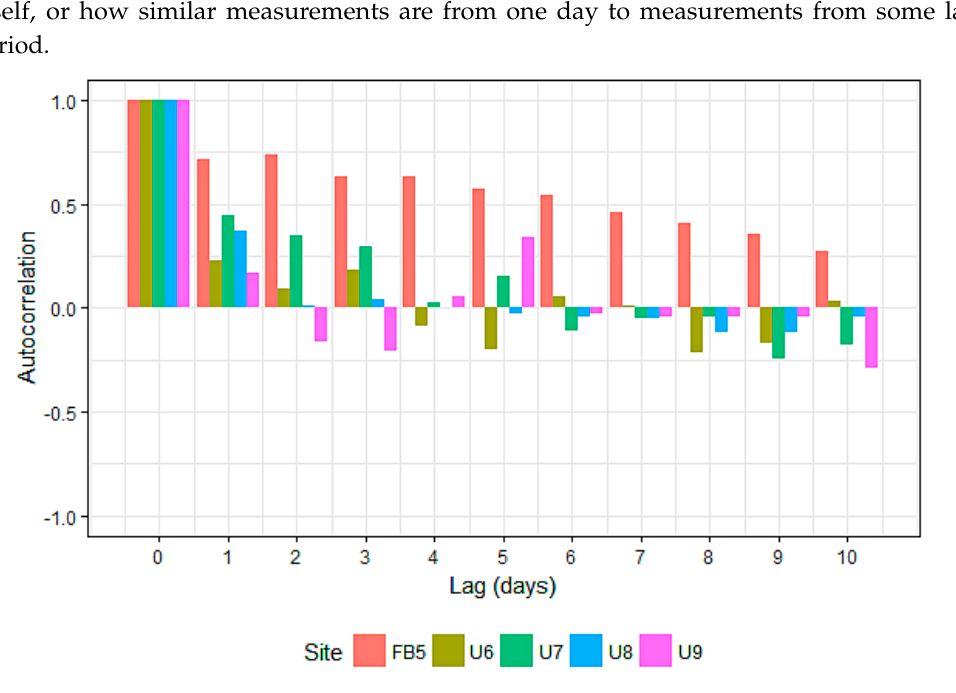
Figure 2. Autocorrelation for Utah Lake (U6, U7, U8 and U9) and Farmington Bay (FB5) Sites.